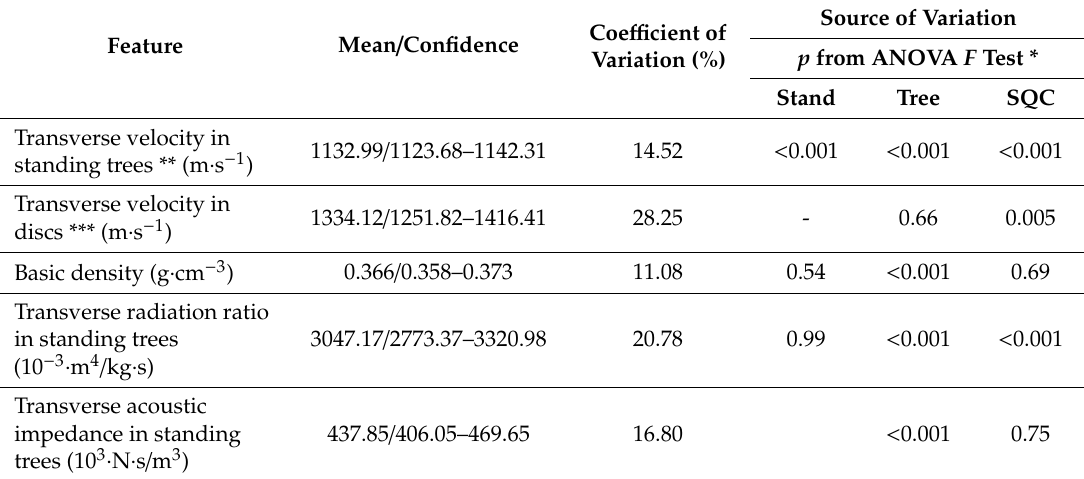
Table 6. Variation sources of acoustic features of spruce wood in stands with resonance wood from the Gurghiu Mountains (the Romanian